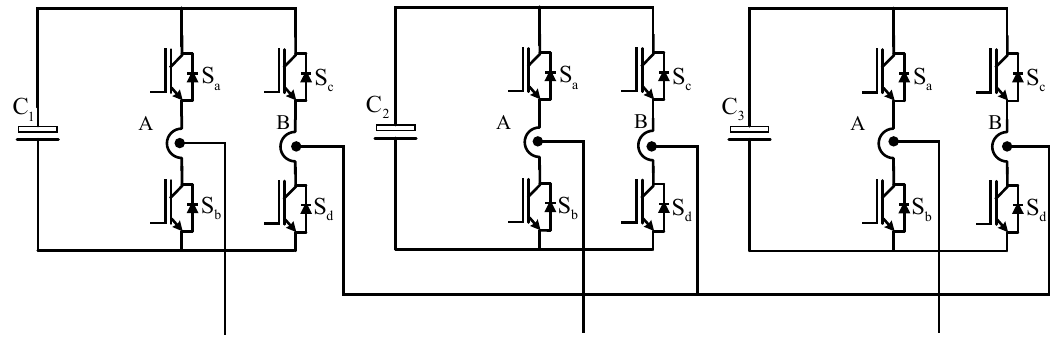
Figure 6. Cascaded H-bridge multilevel inverter.